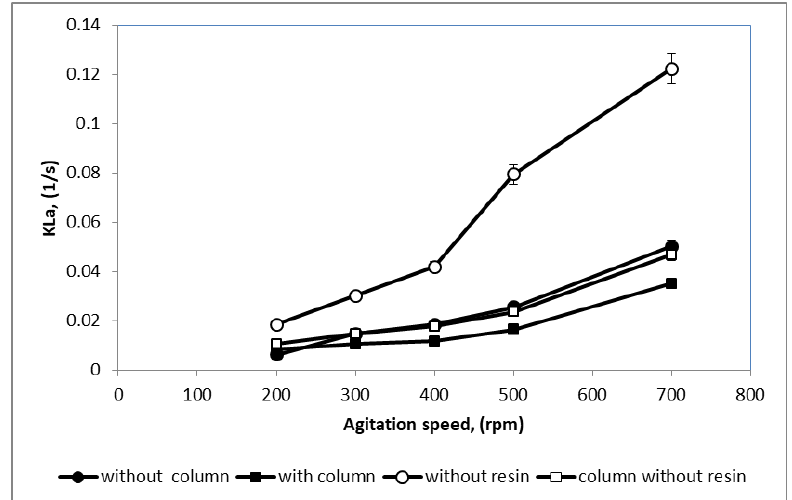
Figure 2. Comparable values of k L a for the 2 L stirred-tank bioreactor. ( ○ ) bioreactor without column no resin; (●) bioreactor with dispersed Amberlite IRC 86 resin (no column); (□) bioreactor with internal column without resin; ( ■ ) bioreactor with Amberlite IRC 86 resin in an internal column.